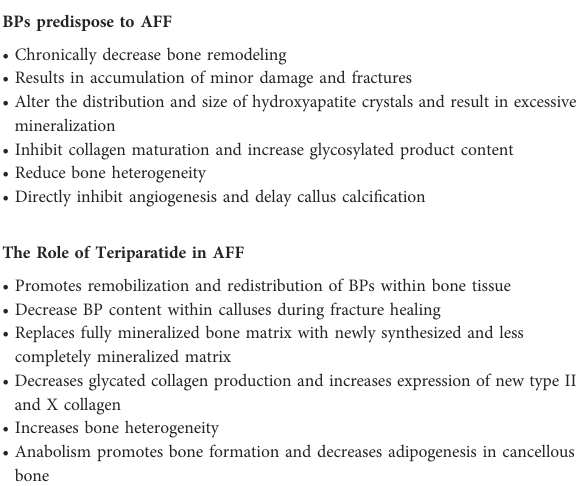
to exhibit focal lateral cortical thickening, or transverse, short oblique fracture lines as the stress reaction develops.